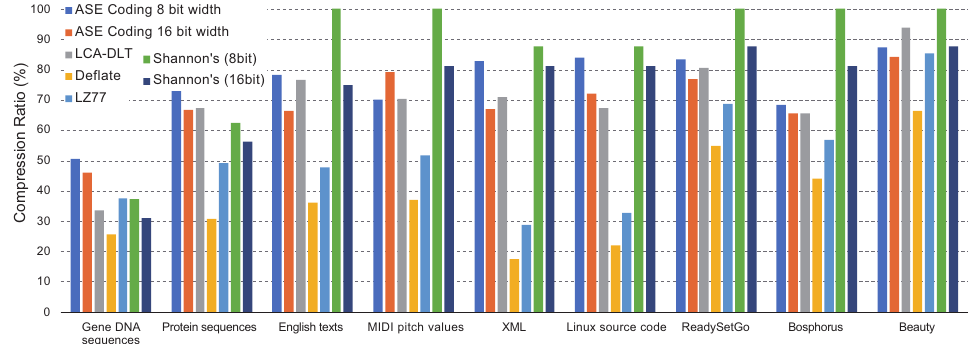
Figure 7. Comparisons of compression ratios among ASE coding (8/16 bit symbol input) and the conventional